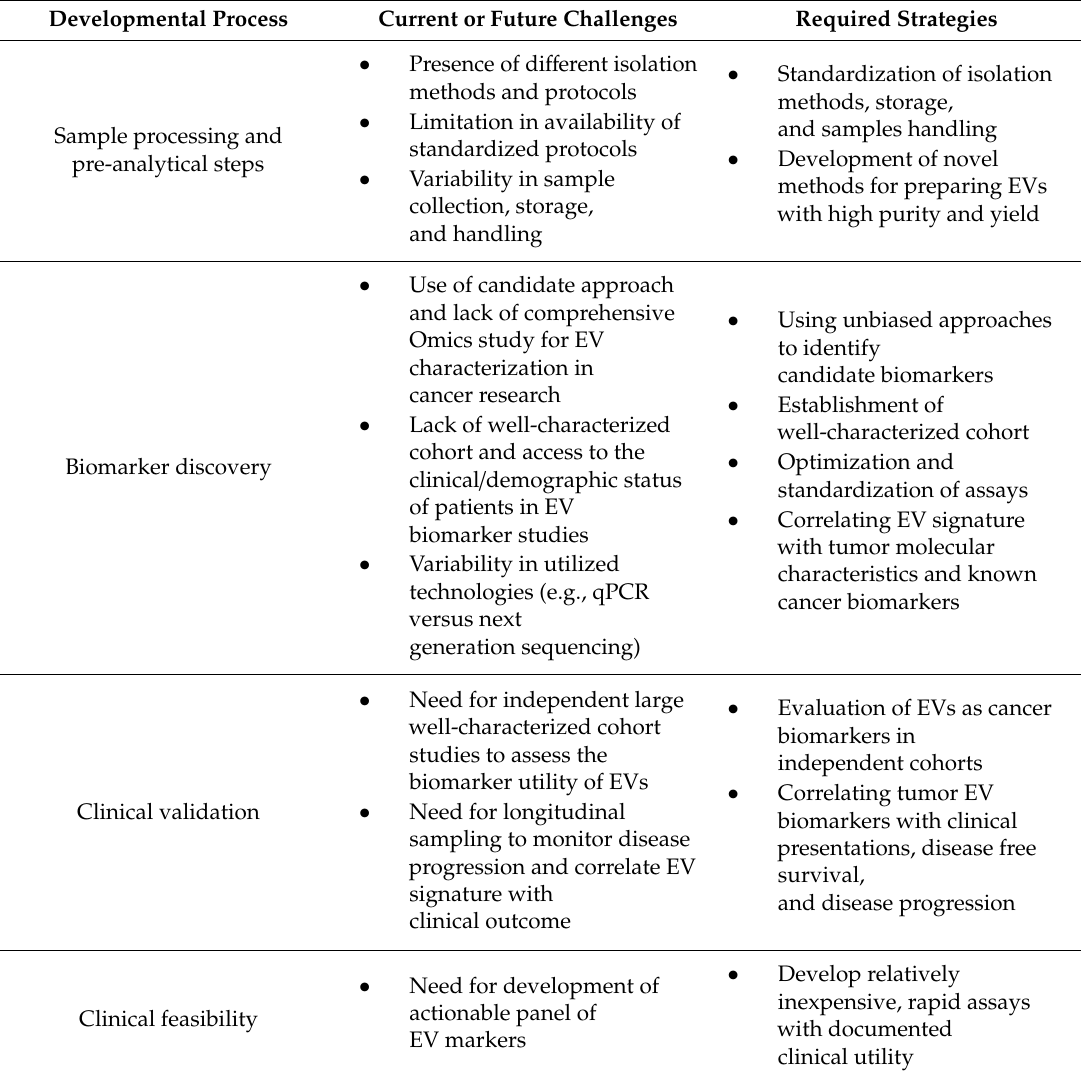
Table 2. Current challenges in the development of EV-based cancer biomarkers and suggested strategies to overcome the